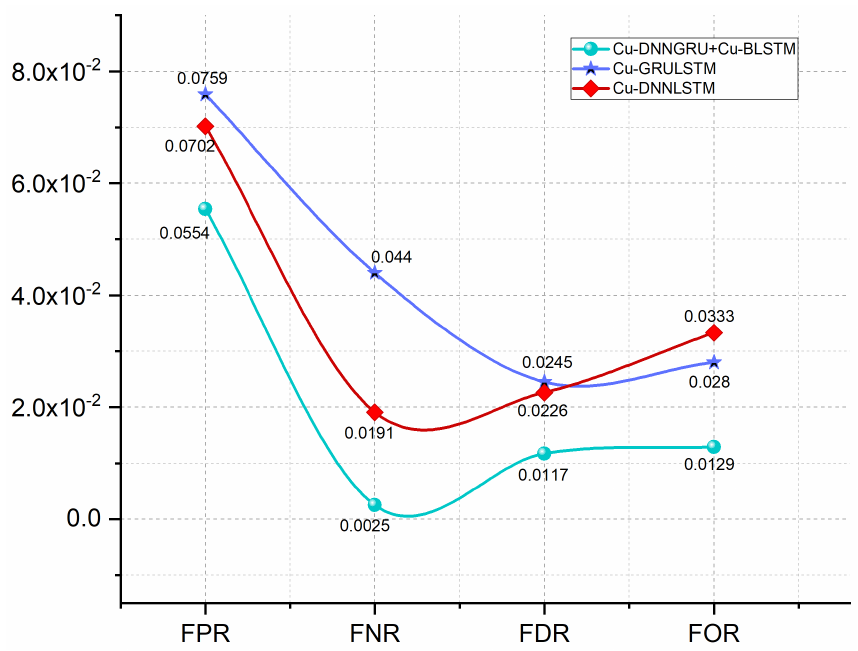
Figure 6. Achieved values of FPR, FNR, FDR, and FOR.